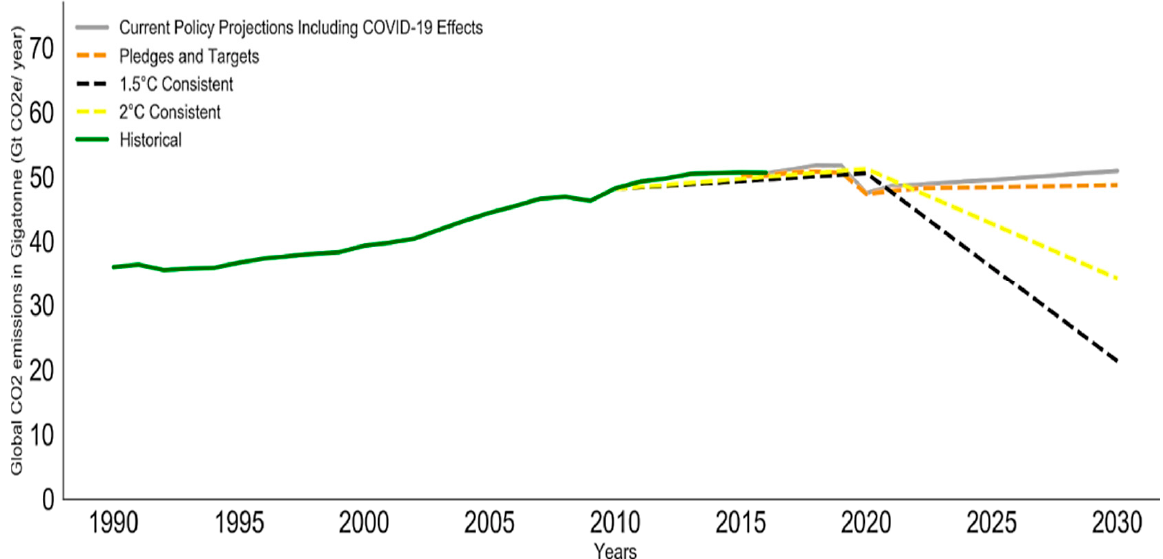
Figure 1. The global CO 2 performance and the temperature reduction plan (data obtained from climate action tracker (2020). The 2030 Emissions Gap. Updated September 2020. Copyright © 2020 Climate Analytics and New Climate Institute. All rights reserved [6]).